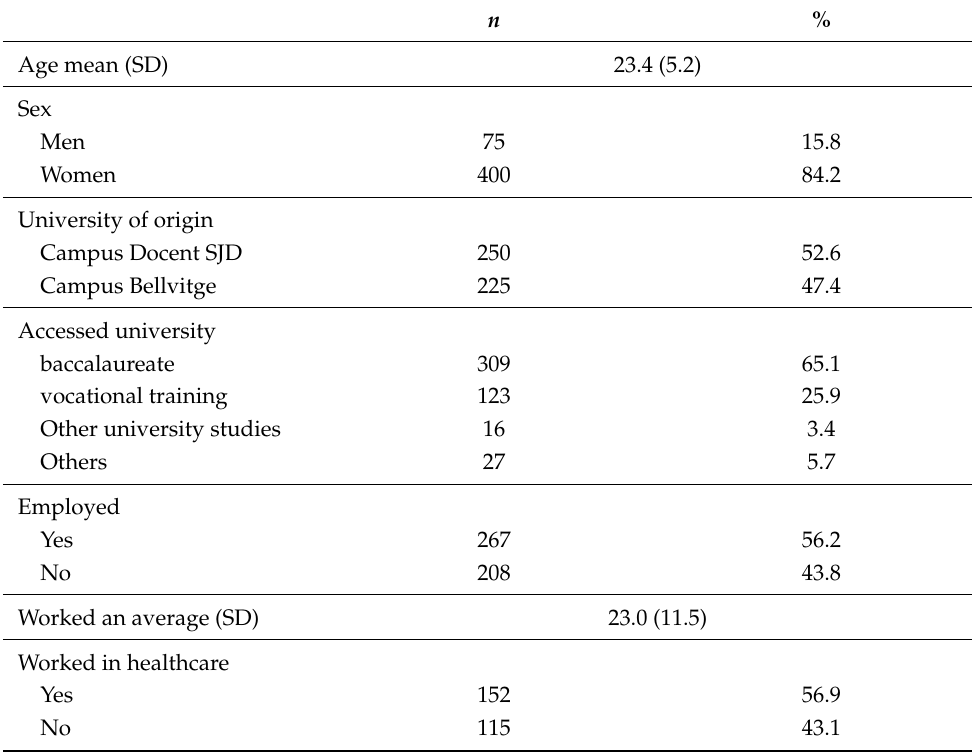
Table 2. Sociodemographic characteristics of the study population ( n = 475).